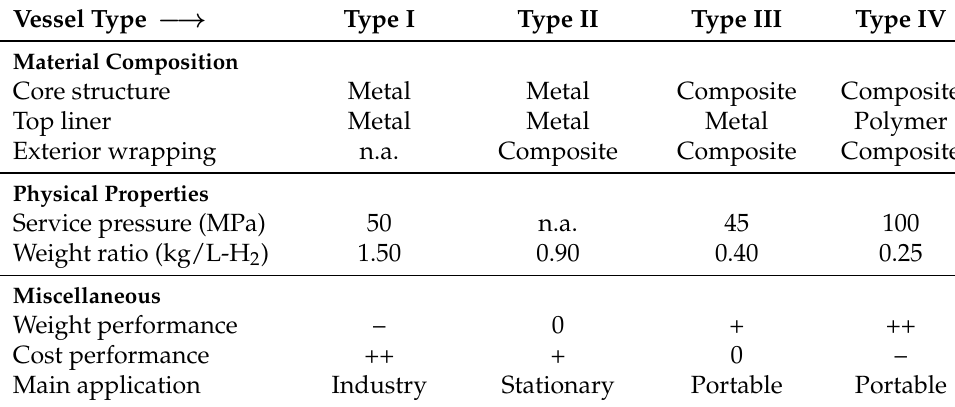
Table 1. Major features of compressed hydrogen storage